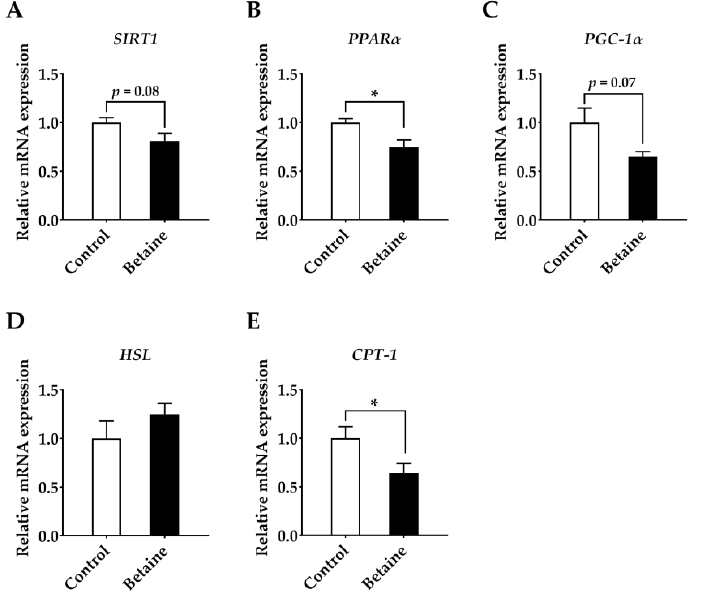
Figure 5. Effects of betaine on lipolysis genes in longissimus lumborum muscle of growing-finishing pigs. ( A ) SIRT , silent information regulator of transcription 1; ( B ) PPARα , peroxisome proliferator- activated receptorα; ( C ) PGC- 1α , peroxisome proliferator-activated receptor gamma coactivator-1 α; ( D ) HSL , hormone-sensitive lipase; ( E ) CPT1 , carnitine palmitoyl transferase 1. * p < 0.05 versus the control group.